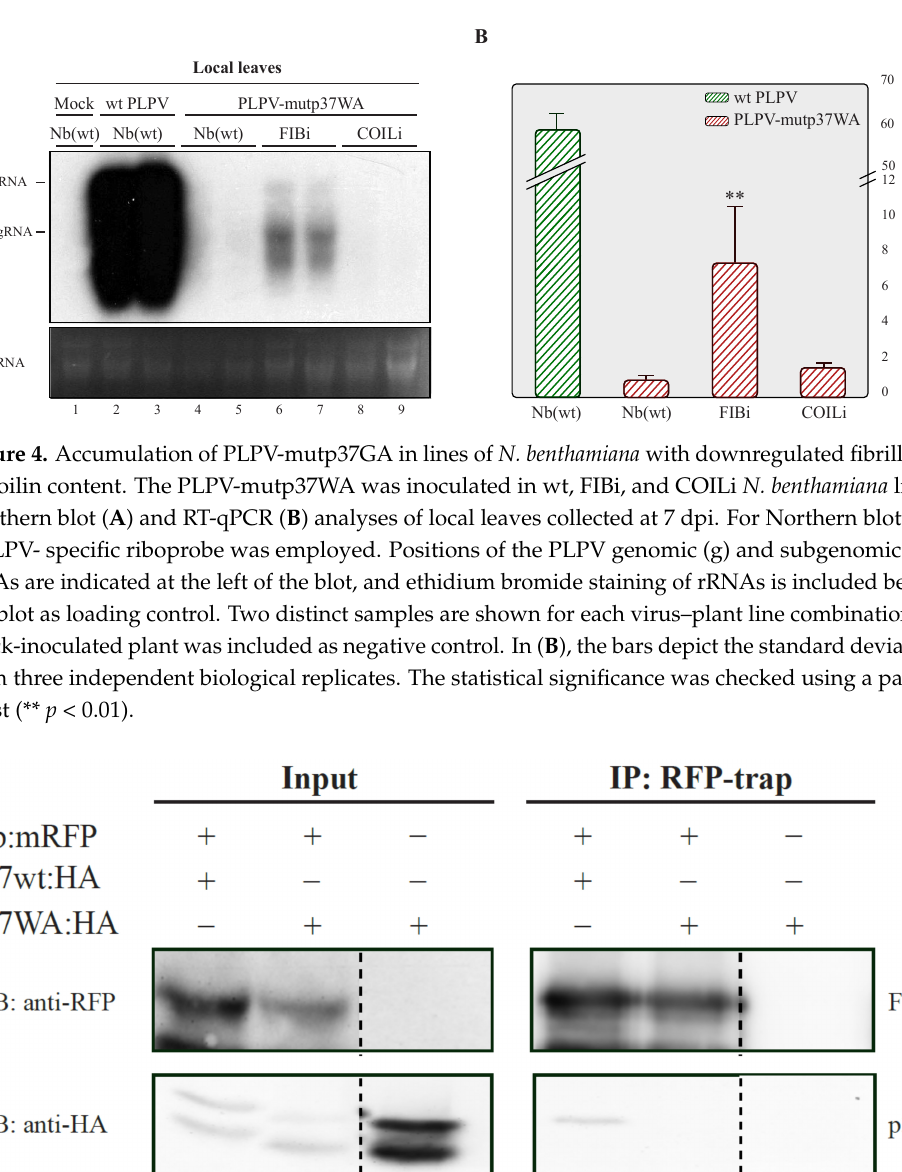
Figure 5. Analysis of fibrillarin interaction with wt p37 and mutant p37WA through a co-immuno- precipitation assay. FIB:mRFP was co-expressed with HA-tagged wt p37 or p37WA in N. bentham- iana leaves. N. bentamiana leaves expressing only HA-tagged p37WA were included as control. Input protein extracts or immunoprecipitates (IP) obtained with the employment of ChromoTek RFP-Trap agarose were subjected to Western blot (WB) analysis using either an anti-RFP antibody (for detec- tion of fibrillarin; upper blot) or anti-HA antibody (for detection of p37 molecule; lower blot).